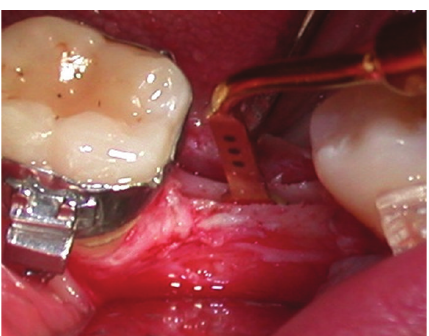
Figure 10: Midcrestal bone